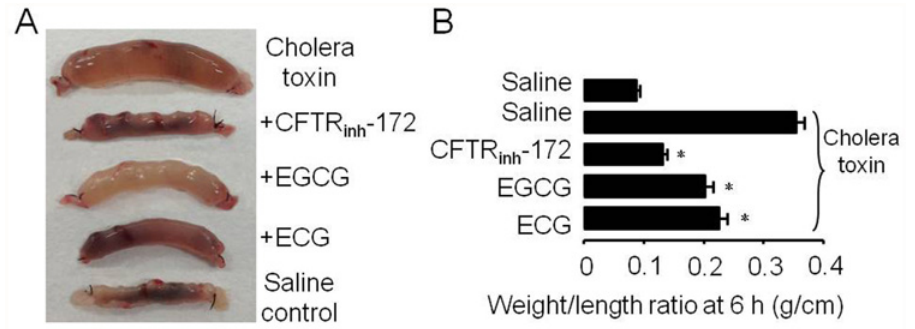
Fig 6. Inhibition of intestinal fluid secretion by EGCG and ECG. A. Photograph of isolated mouse ileal loops at 6 hours after lumenal injection of saline, 0.5 μ g cholera toxin, 0.5 μ g cholera toxin plus 10 μ g EGCG (or 10 μ g ECG, or 2 μ g CFTR inh -172). (B) Ratio of loop weight/length (g/cm) at 6 hours before versus after luminal fluid removal (SE; six mice per group; * p <